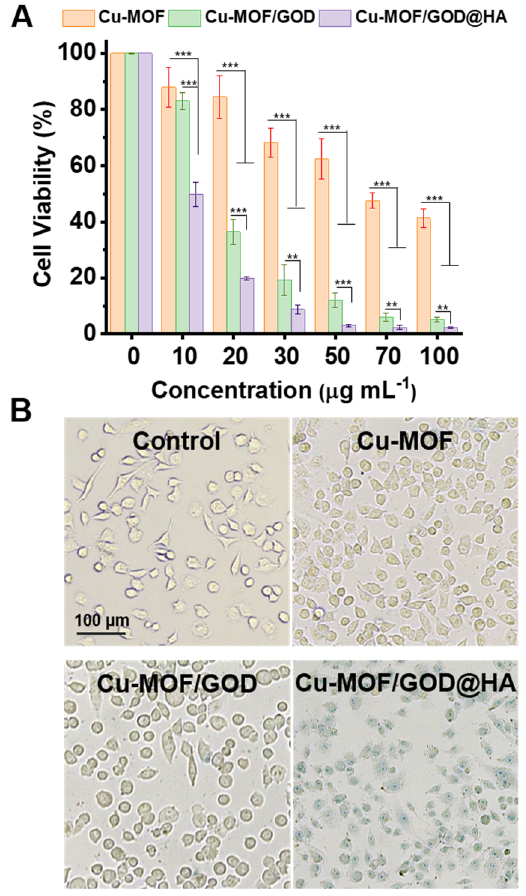
Figure 5. Cytotoxicity of different nanocomposites under different conditions. ( A ) MCF-7 cells were incubated with Cu-MOF, Cu-MOF/GOD and Cu-MOF/GOD@HA at concentrations of 0, 10, 20, 30, 50, 70, 100 μ g mL –1 . ( B ) Microscopy images of MCF-7 cells with trypan blue staining. MCF-7 cells were incubated with Cu-MOF, Cu-MOF/GOD and Cu-MOF/GOD@HA for 4 h at the levels of 20 μ g mL –1 . Scale bar: 100 μ m. Values of p < 0.05 were considered statistically significant, with *, **, *** represent p < 0.05, p < 0.01 and p < 0.001, respectively.